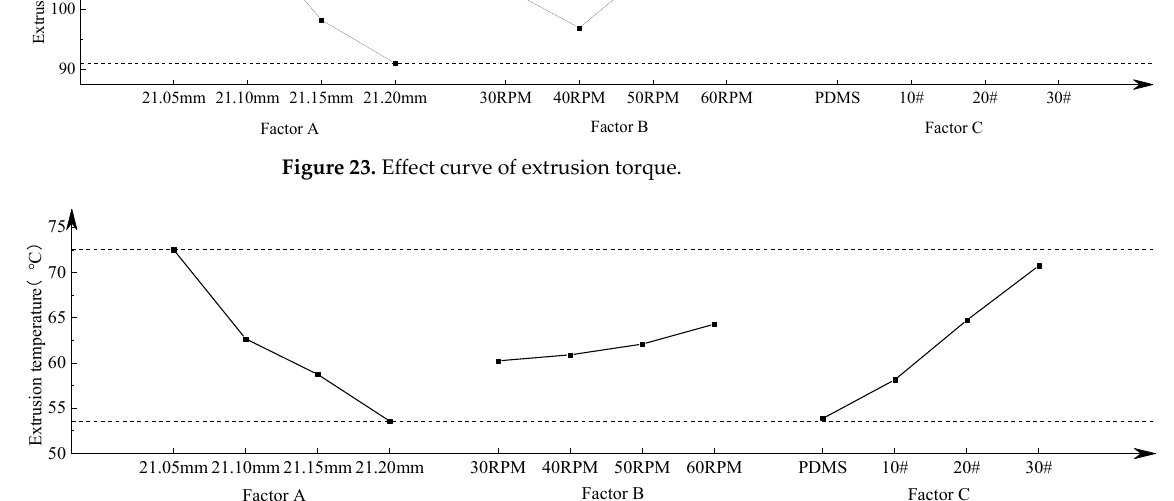
Figure 24. Effect curve of extrusion